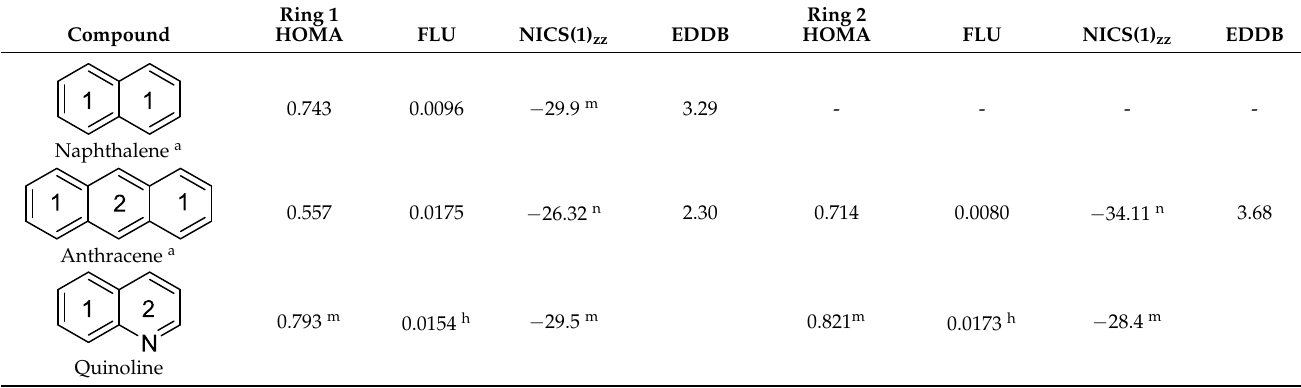
Table 4. Values of aromaticity indices for several polycyclic molecules.